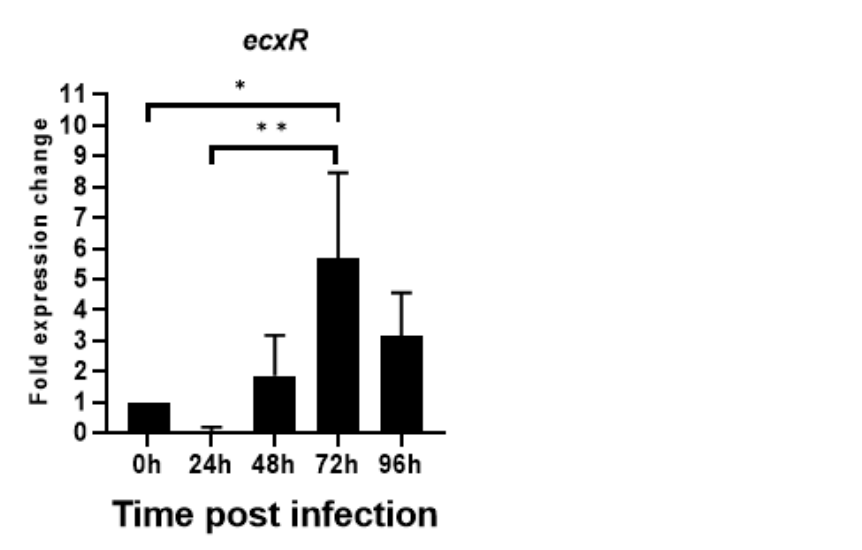
early form of RC [15].